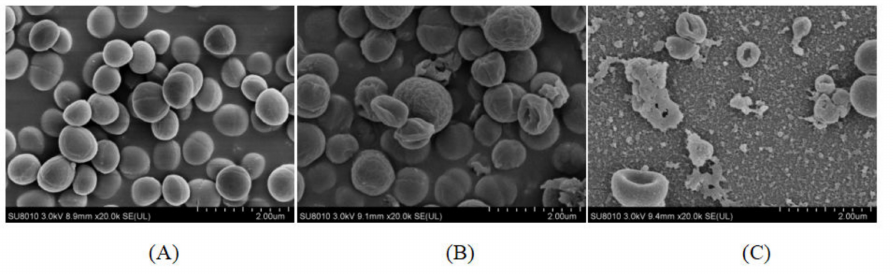
Figure 4. Effect of plantaricin YKX on the cell structure of S. aureus ATCC 25923. ( A ): without plantaricin YKX treatment; ( B ): after treatment with 1 MIC plantaricin YKX for 30 min; ( C ): after treatment with 1 MIC plantaricin YKX for 2 h.